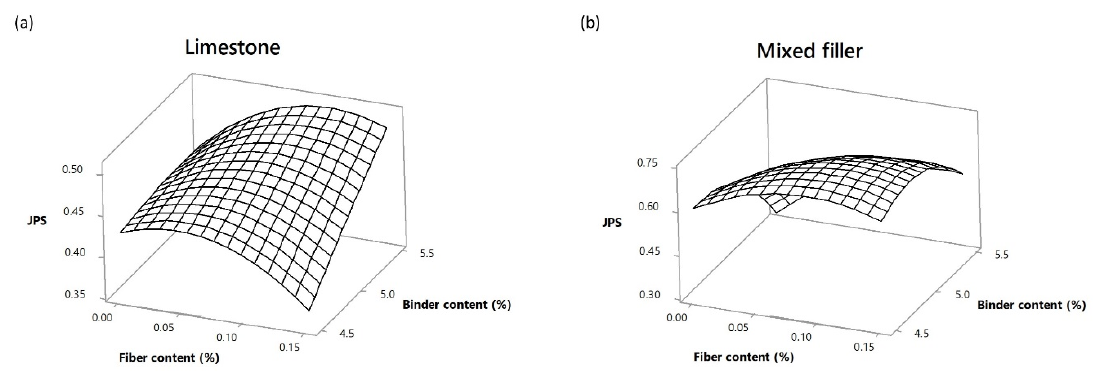
Figure 16. Fiber–binder interaction effect on JPS value. ( a ) Limestone. ( b ) Mixed filler.